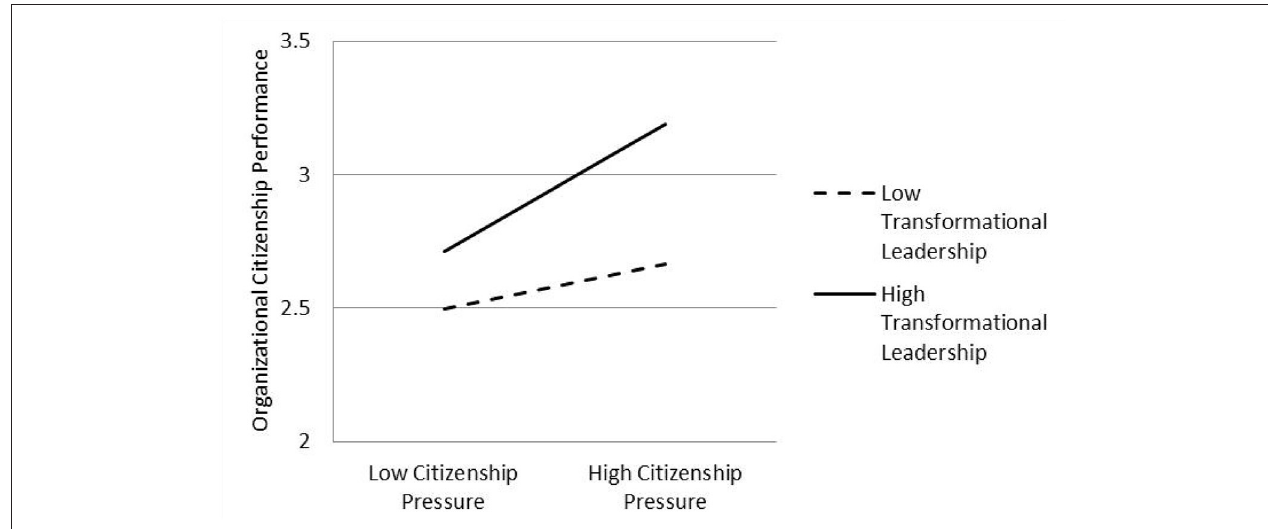
FIGURE 2 | The moderating role of transformational